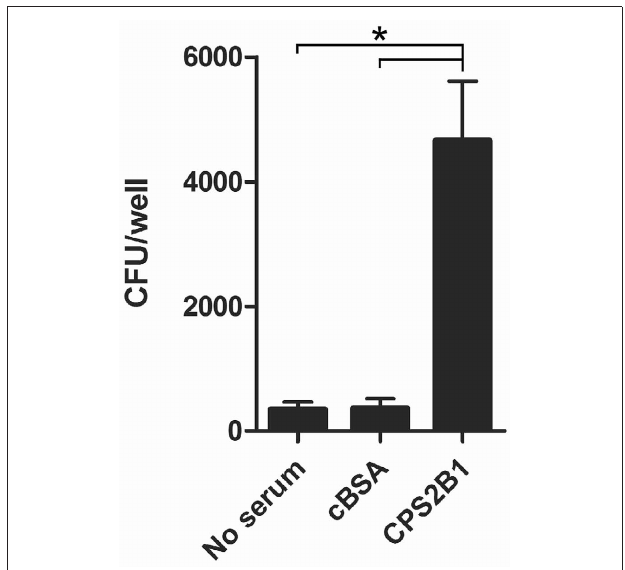
FIGURE 6 | Opsonophagocytic uptake of B. mallei by RAW 264.7 murine macrophages. Bacterial uptake in the presence of DMEM alone (no serum), pooled HI anti-cBSA immune serum (cBSA; n = 6) or pooled HI anti-CPS2B1 immune serum (CPS2B1; n = 6) was quantitated at 3h post-infection. Values represent the means ± SD of three independent experiments. ∗ , P < 0 . 05.